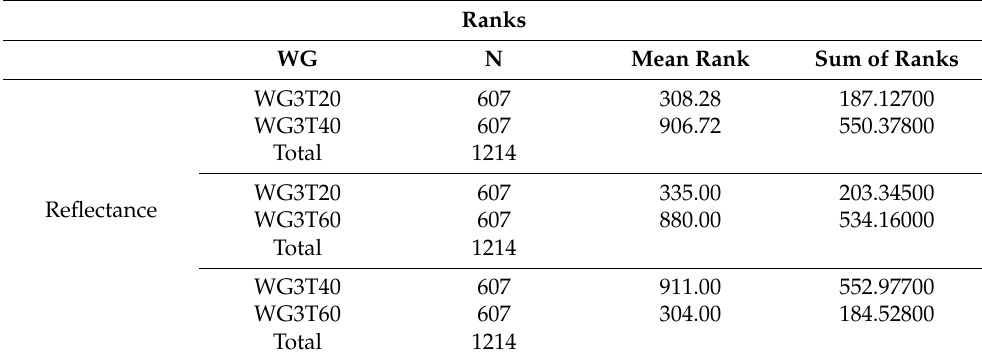
Table A19. Ranks table of Mann–Whitney U test for specular solar reflectance of WG3 during the three holding time.